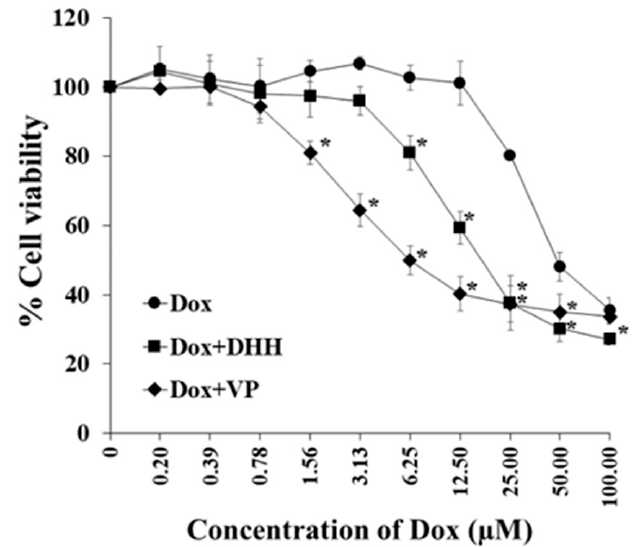
Figure 5. Effect of DHH on the cytotoxicity of Dox. K562/ADR cells (1.0 × 10 4 cells/well) were cultured in 100 µ L medium in the presence of 0.5% DMSO, with 22 µ M verapamil (VP) or 55.6 µ M DHH in the presence of different concentrations of Dox. The viable cells were determined using an MTT assay. The data are shown as mean ± SD from 3 independent experiments performed in triplicate. The significance of mean differences was assessed using one-way ANOVA. * p < 0.05 as compared with Dox treatment.